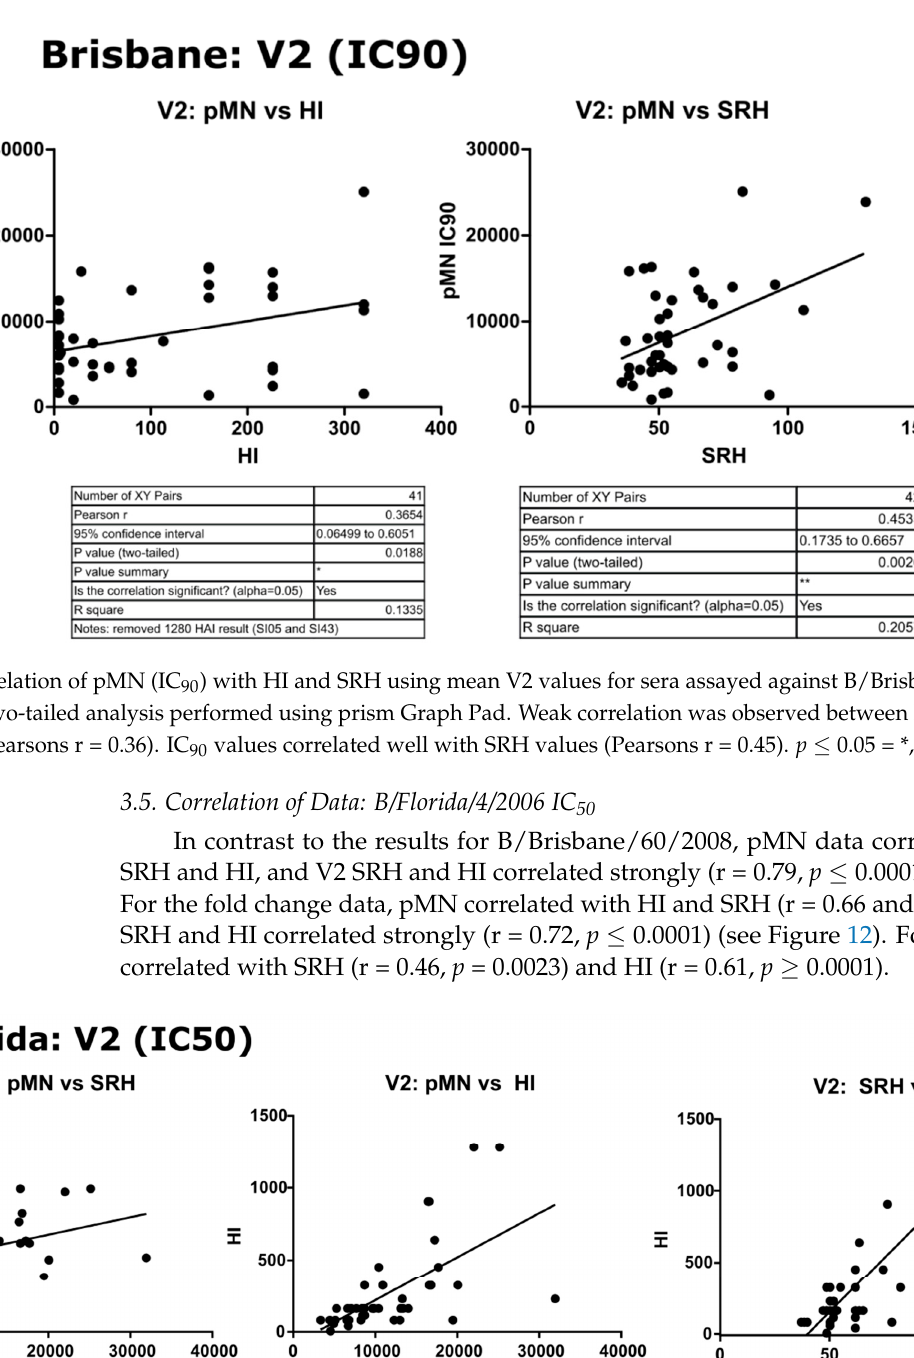
Figure 9. Correlation of transformed (log10) data for pMN (IC 90 ) with HI and SRH using mean V2 values for sera assayed against B/Brisbane/60/2008 PV. Pearson’s two-tailed analysis performed using GraphPad Prism. Weak correlation was observed between log IC 90 antibody titres and log HI or SRH values (Pearsons r = 0.23 and 0.32, respectively). p > 0.05 = ns, p ≤ 0.05 = *.